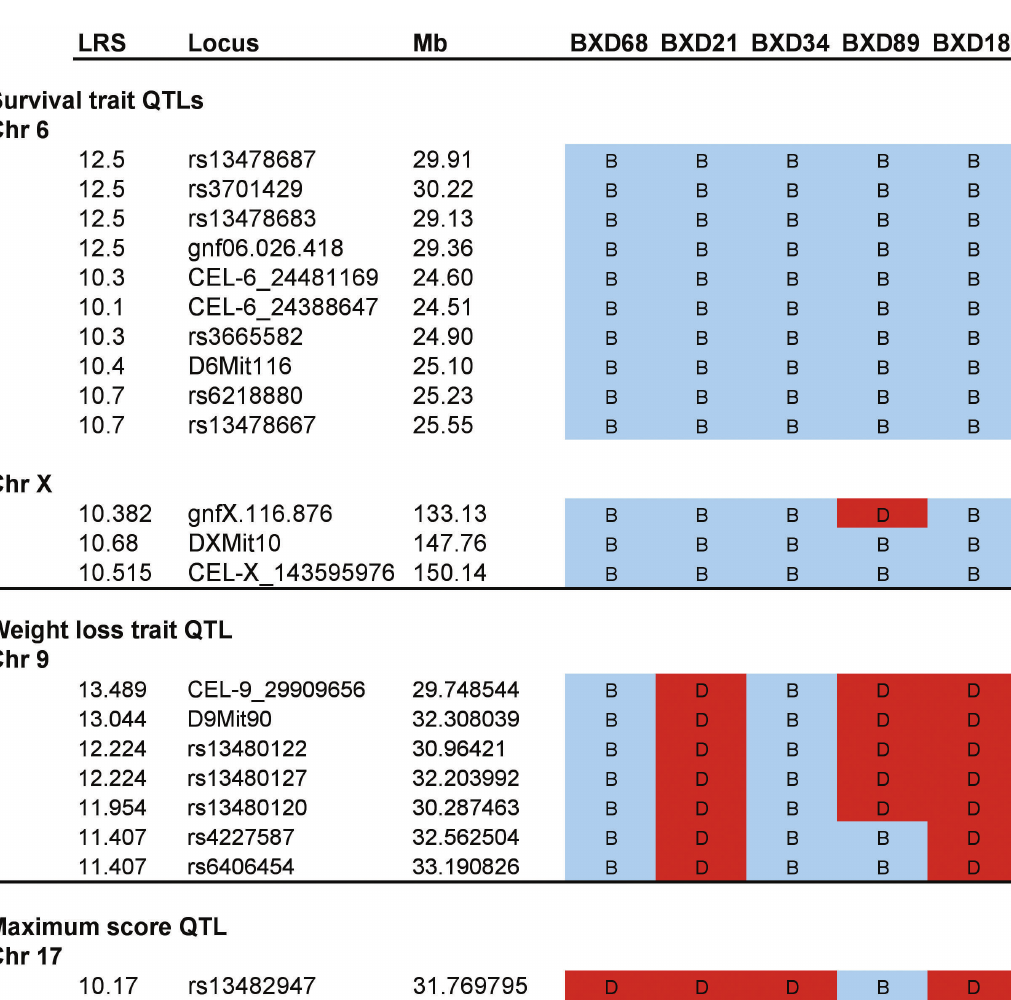
Figure 9. Linkage analysis and haplotype mapping of preliminary survival QTLs. ( a ) Linkage analysis of QTLs associated with differential response post-exposure to aerosolized MA-EBOV. Linkage analysis of highest LRS of QTLs associated with differential survival, percent weight loss and maximum score. For each mapped trait, haplotypes of BXD strains showing highest lethality post-exposure to MA-EBOV (BXD68, BXD21, BXD34, BXD89 and BXD18) are analyzed. ( b ) Strain distribution patterns (SDP) and haplotype map of all available BXD strains at the most promising QTL mapped on chromosome 6. “B” = allele from C57BL/6 and “D” = allele from DBA/2